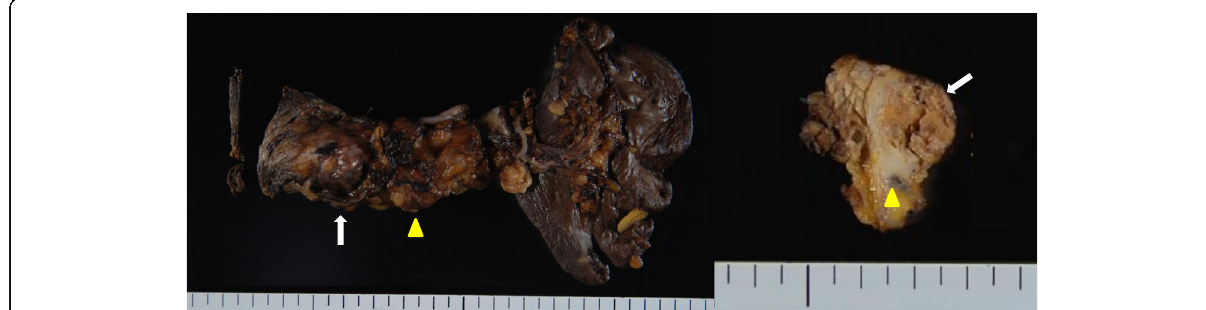
Fig. 3 Macroscopic examination of the resected specimen. Macroscopic examination of the resected specimen showing a 20-mm hard mass (white arrow) and a 38-mm well-circumscribed nodule just distal to the mass (yellow arrowhead) in pancreatic